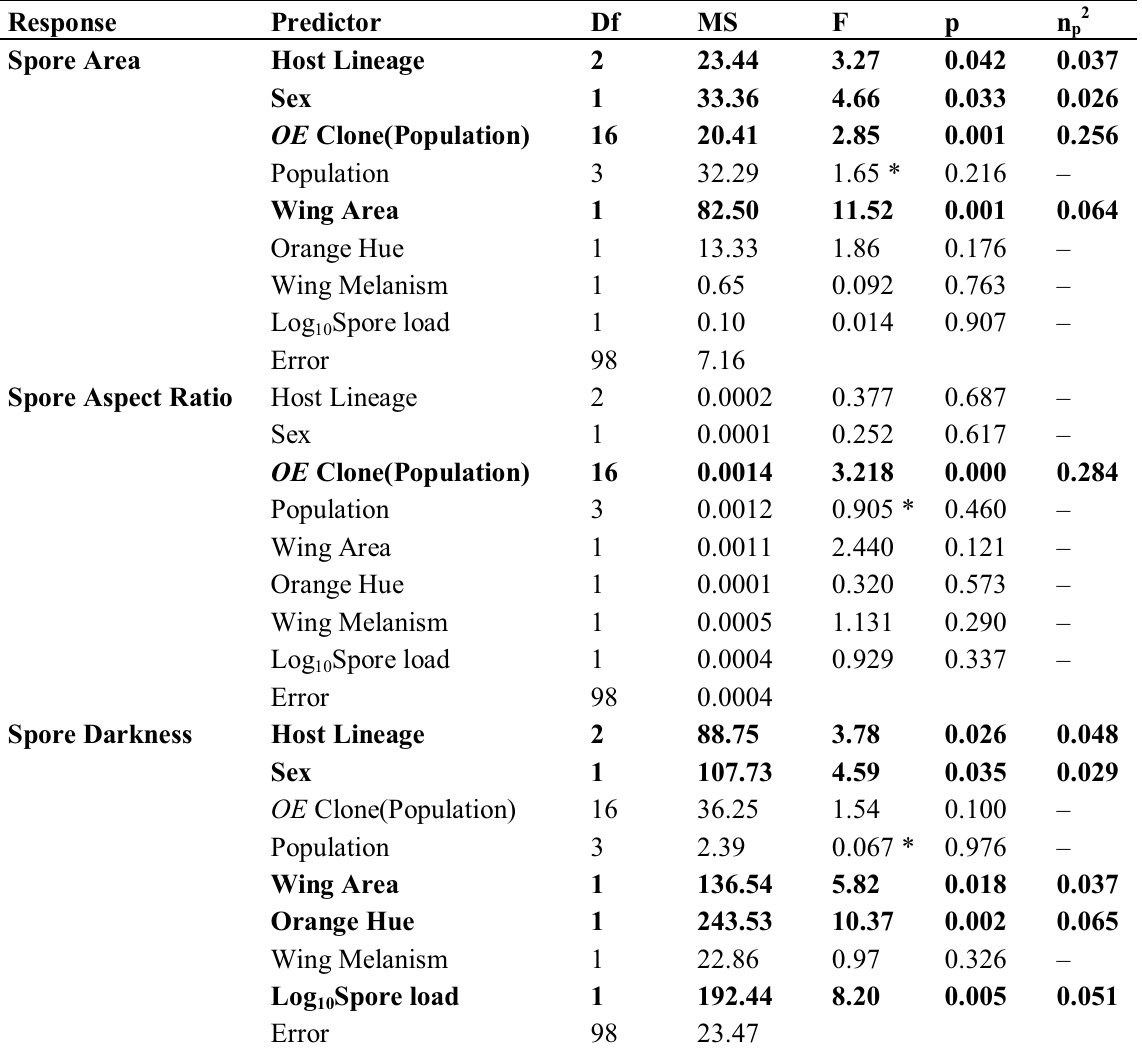
* F-statistic for population effect used clone (population) MS as error term in denominator. All other tests use mean square error as denominator for